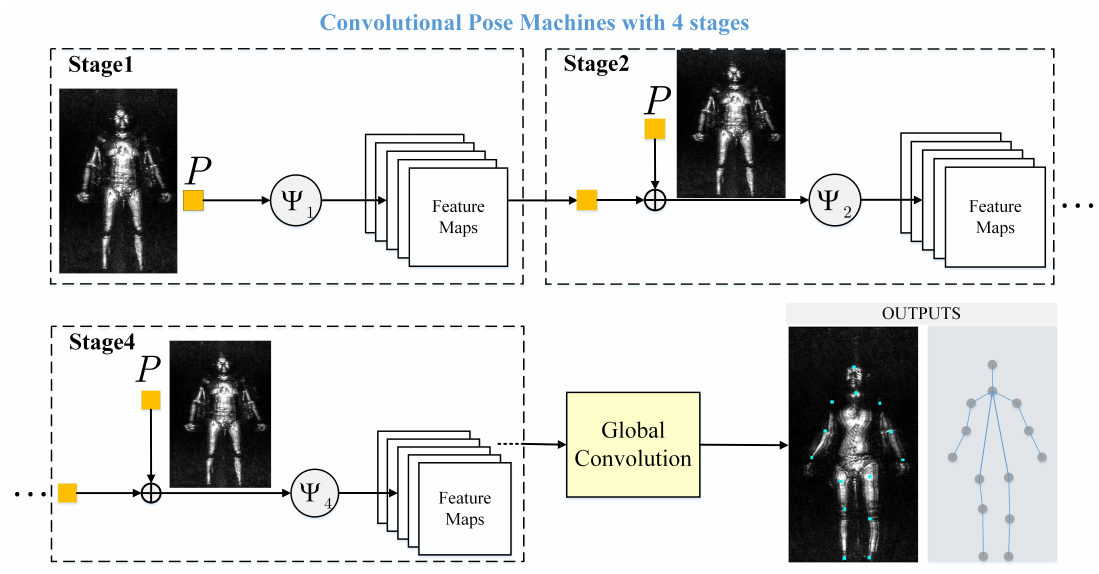
Figure 2. Improved convolution pose machine (CPM) with four stages. The original CPM is reduced from six stages to four stages and the global-convolution (GCN) layer is used rather than fully-connected (FCN)